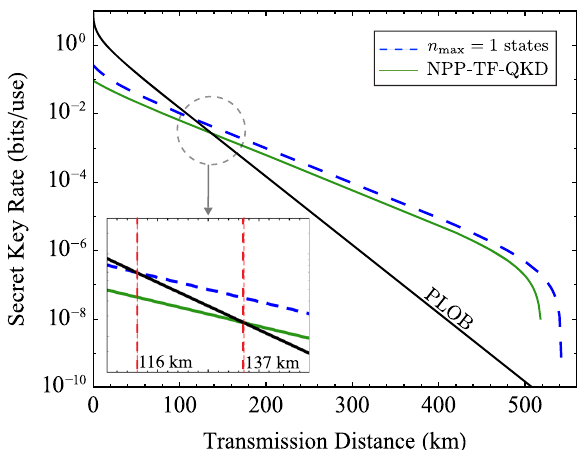
Fig. 6 Simulation results of our repeater protocol using single- photon states with experimental parameters. The blue dashed line shows our protocol using the single-photon states in the form of ffiffiffiffiffi ffiffiffiffiffi ffiffiffiffiffi ffiffiffiffiffi p p p p 00 j i þ b 1 11 j i with optimised coef fi - 00 j i þ a 1 11 j i and b 0 a 0 cients and perfect single-photon sources. The solid green line and black lines are the NPP-TF-QKD protocol 60 with in fi nite decoy states and the PLOB bound, respectively. We assume a dark count rate of 5 × 10 − 8 with a detector ef fi ciency of 0.85 for both the measurement results of the X and Z bases. These two differences yield a higher key rate than the results of ref. 63 . states are optimised for a detector with an ef fi ciency of 85% and a dark count rate of 5 × 10 − 8 , where the coef fi cients of the zero and However, as the channel becomes more lossy, it is likely that the single-photon will be lost during transmission. When Charlie receives no photons, this corresponds to a large bit-error rate reducing the key rates. This is compensated by reducing the probability of sending single-photons to decrease the bit-error rates and increase the key rates 64 . With realistic dark count rates and detector ef fi ciencies, our protocol using perfect single-photon sources surpasses the PLOB bound at 116 km while the NPP-TF- QKD with in fi nite decoy states surpasses at 137 km as shown in Fig. 6. The NPP-TF-QKD protocol drops to zero beyond 518 km whereas our protocol drops to zero beyond 542 km showing a 24 km advancement in the transmission distance. To account for a more practical scenario, we simulate our protocol with imperfect single-photon sources and compare it with the NPP-TF-QKD protocol 60 with a fi nite number of decoy states. When the single-photon sources used by Alice and Bob are heralded with imperfect detectors with a dark count rate of 5 × 10 − 8 and a detector ef fi ciency of 0.85 for state preparation, the single-photon protocol achieves a total transmission distance of 480 km assuming 0.2 dB loss per km. When NPP-TF-QKD proto- col 60 uses fi nite decoy states with two decoy modes with four intensities and the same dark count rates and detector ef fi ciencies, the protocol achieves a total transmission distance of 470 km. Using a more realistic experimental set-up our protocol still performs better. However, as the heralding detectors used by Alice and Bob for the state preparation get more lossy, our protocol is likely to start performing worse than the TF-QKD protocols as these protocols use coherent states. Current super- conducting nanowire single-photon detectors can achieve detec- tor ef fi ciencies up to 90% with dark count rates as low as 10 − 9 as demonstrated previously in ref. 40 .